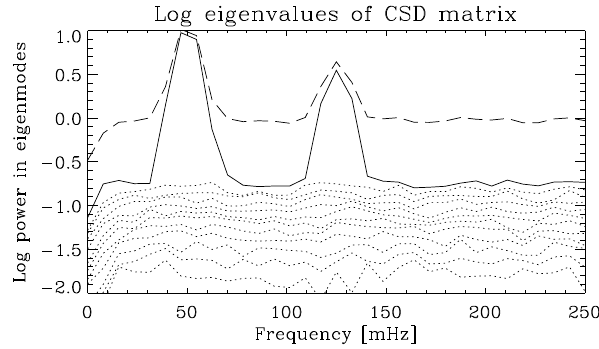
Fig. 2. Demonstration of the wave surveyor technique. Eigenvalues and trace of the CSD matrix as functions of frequency f = ω/ 2 π . First eigenvalue: solid line. Remaining eigenvalues: dotted lines. Trace of the CSD matrix: dashed